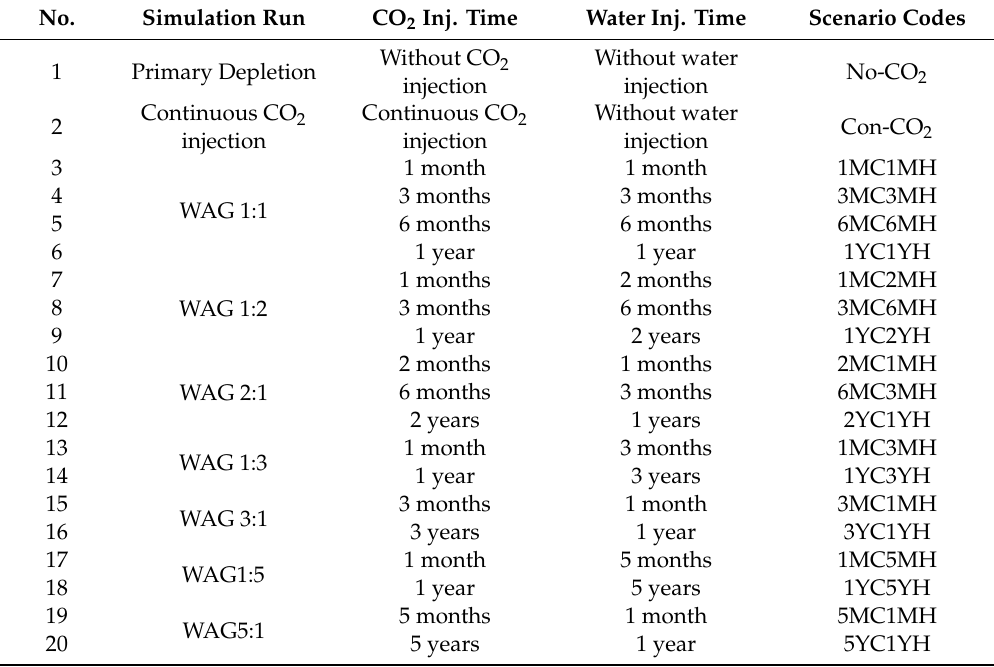
Table 5. Description of di ff erent scenarios designed in